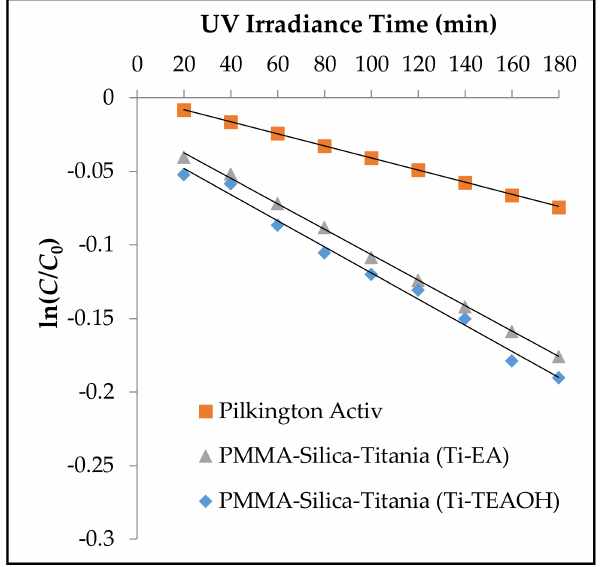
Figure 6. Logarithmic plot of the decomposition of methylene blue as a function of UV exposure time for a commercial Pilkington Activ ® sample and Ti-EA- or Ti-TEAOH-coated PMMA-SiO 2 samples (both microwaved at 140 ◦ C for 30